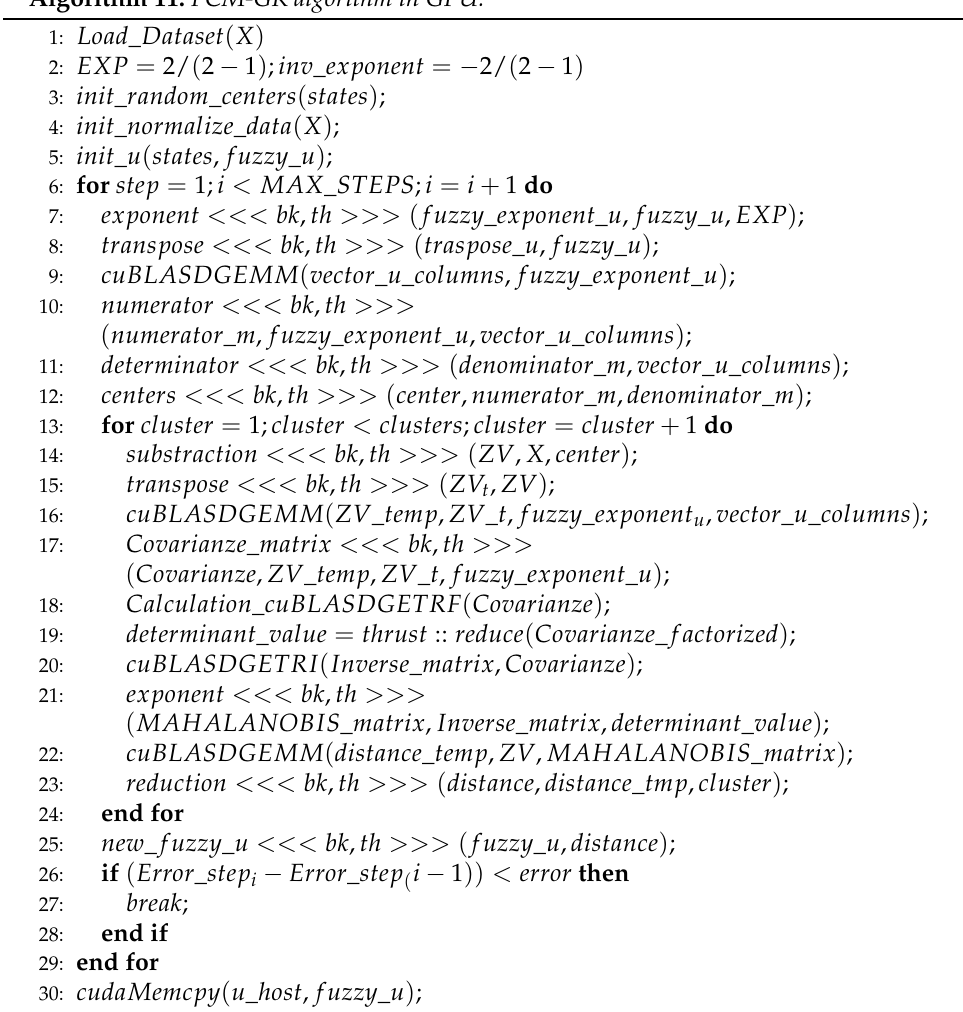
Algorithm 11: FCM-GK algorithm in